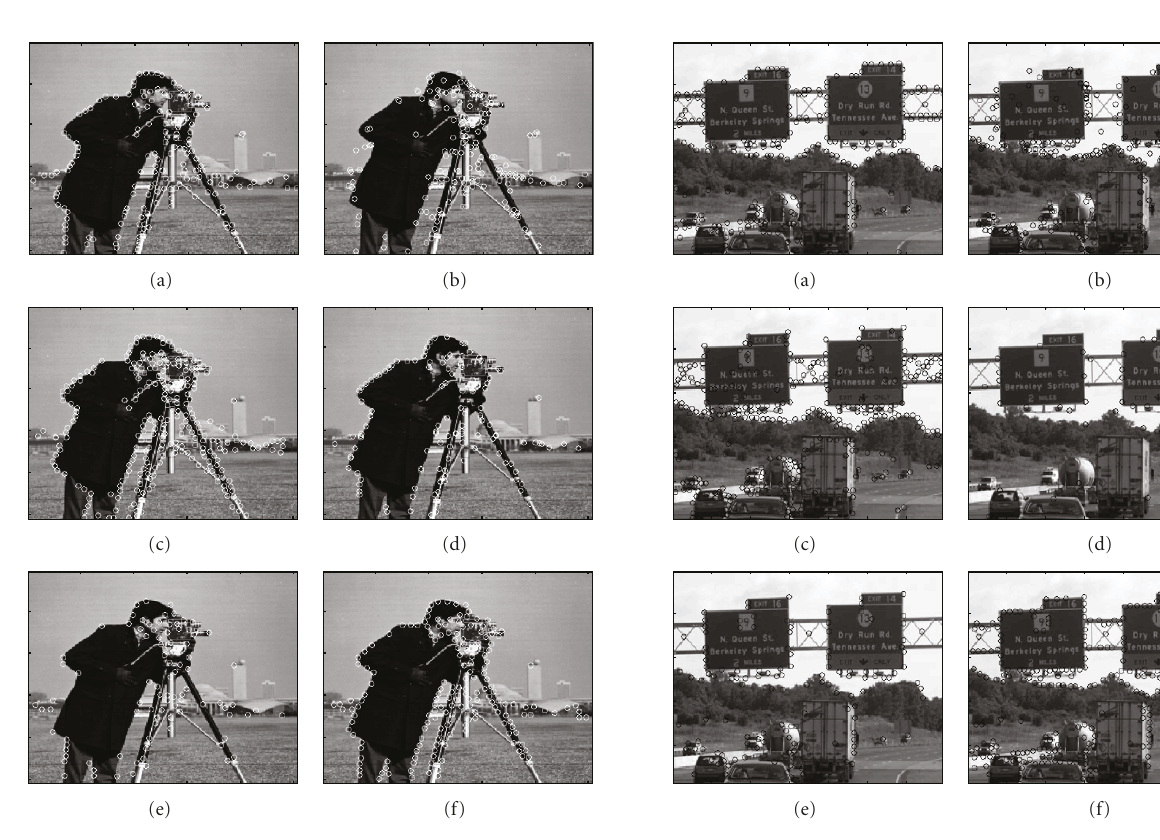
Figure 15: Feature points detected in the third image by (a) Harris method (b) Lowe’s method, (c) Tomasi’s method, (d) Loupias’s technique, (e) Yeh’s algorithm, and (f) proposed